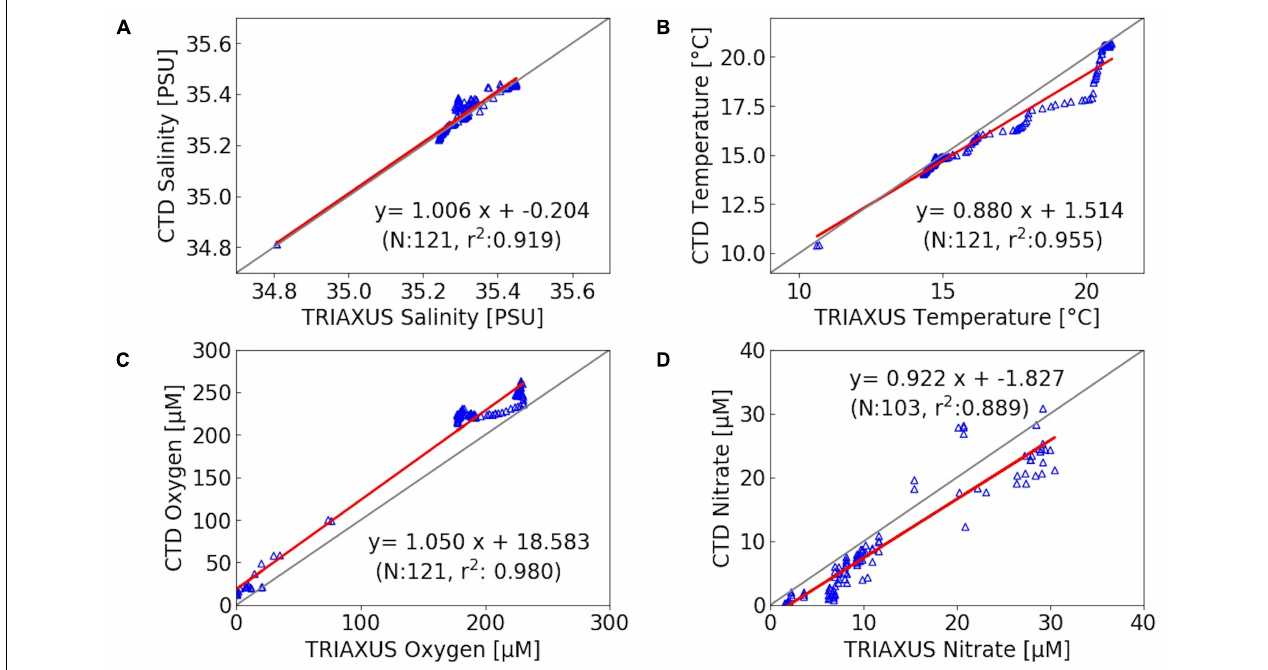
FIGURE 3 | Correlation between TRIAXUS records and data from CTD stations within a 2 km radius (at equal water depths) of salinity (A) , temperature (B) , oxygen (C) and nitrate (D) , with N as number of observations and r 2 as correlation coefficient. The gray and red lines indicate the expected 1:1 line and observed correlation, respectively. Due to a limited number of observations in nitrate, all CTD stations within a radius of approximately 30 km were used. This includes also data from the NBUS where oxygen concentrations were lower than in the SBUS. NBUS observations are not further discussed within this